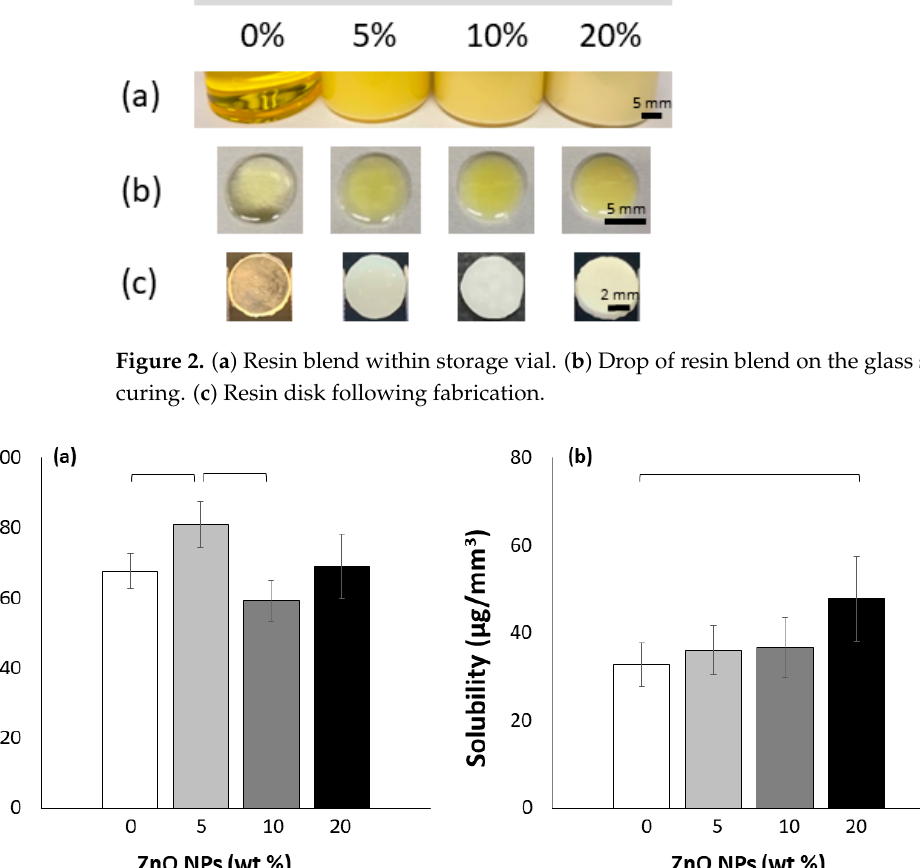
Figure 2. ( a ) Resin blend within storage vial. ( b ) Drop of resin blend on the glass slide prior to light curing. ( c ) Resin disk following fabrication.